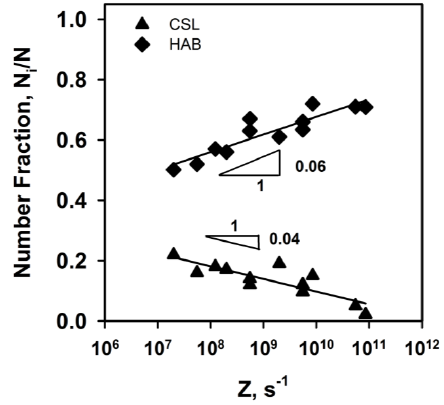
Figure 8. Dependences of the fractions of HAB and CSL boundaries on the temperature-compensated strain rate ( Z ) for the high-nitrogen austenitic stainless steel.